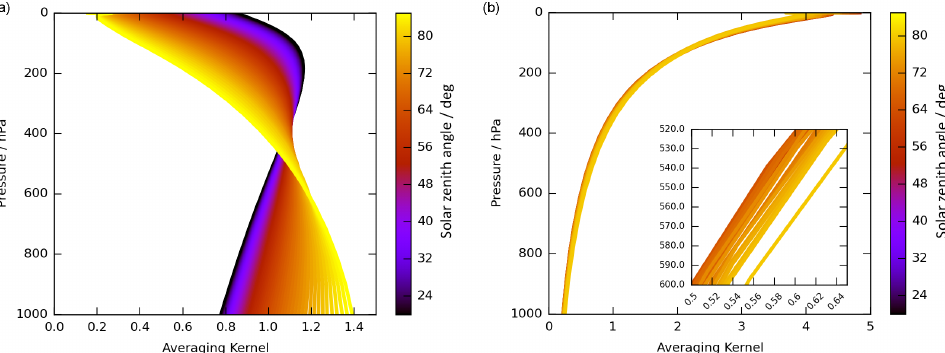
Figure 4. Left: the total column averaging kernels from the TCCON retrievals. The official averaging kernels from the Lamont site, linearly interpolated to obtain intermediate profiles. Note the minimal possible solar zenith angle in Ny-Ålesund is 55 ◦ . Right: the total column averaging kernels from the 2626cm − 1 microwindow as an example NDACC averaging kernel. Note the high sensitivity in the stratosphere and low sensitivity in the troposphere in comparison to TCCON.